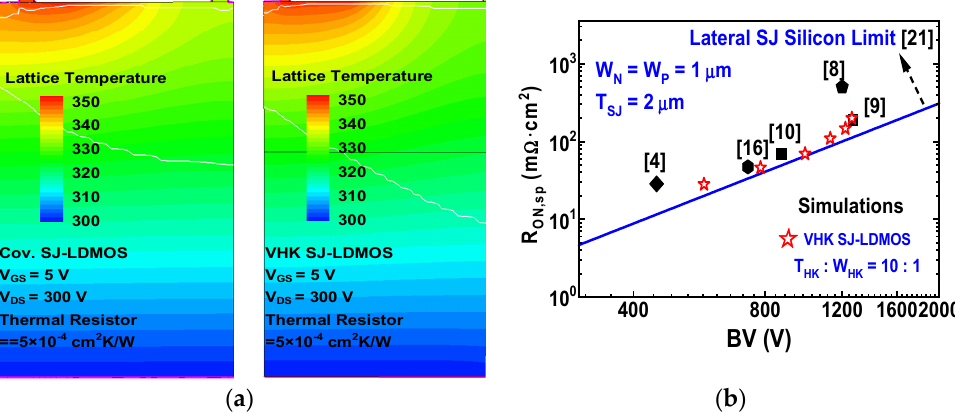
Figure 7. ( a ) Temperature distributions in the conventional SJ-DMOS and VHK SJ-LDMOS, ( b ) com-